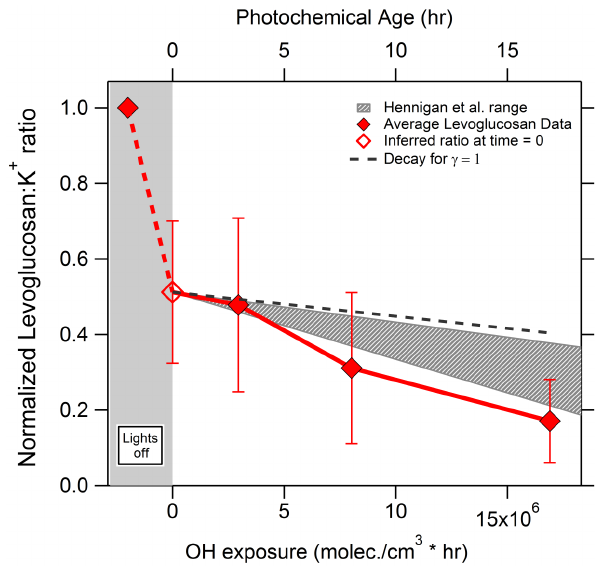
Fig. 7. Evolution of the levoglucosan-to-K + ratio with OH expo- sure. Data are normalized by the initial ratio measured in the com- bustion chamber for each experiment. Solid red symbols represent campaign-average values; the open red symbol is estimated based upon dilution of primary emissions, as described in the text. Error bars represent ± 1 standard deviation. Photochemical age (top axis) assumes a constant OH concentration of 1 × 10 6 moleculescm − 3 . Solid grey region indicates period prior to